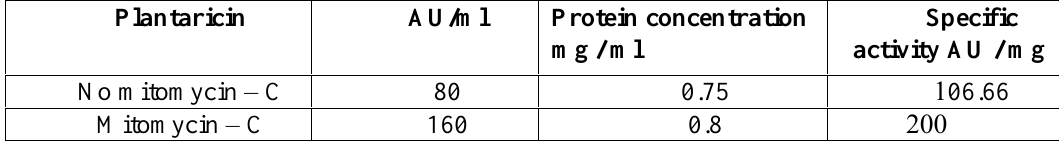
Table (1): Effect of Mitomycin – C on Inducing